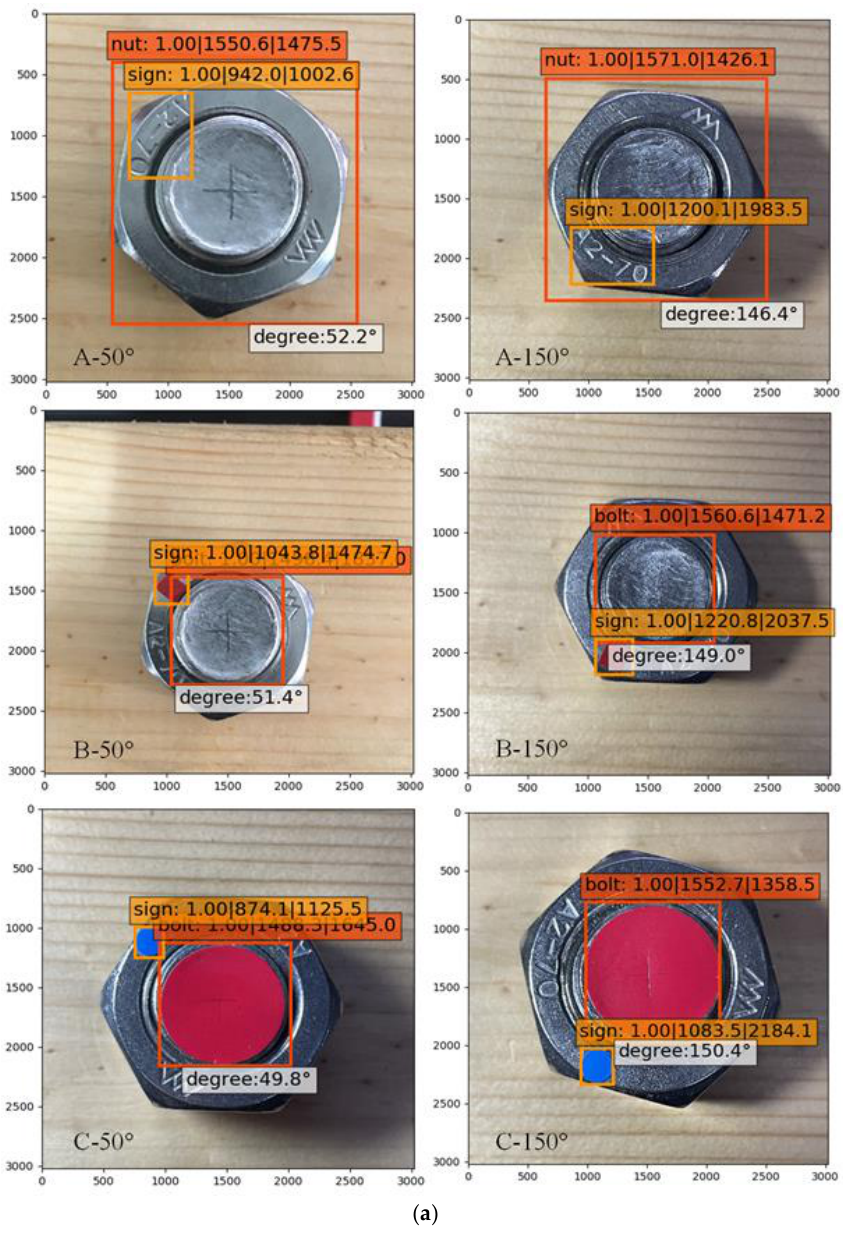
Figure 9. Best identification of rotation angles: ( a ) 50 ◦ and 150 ◦ ; ( b ) 250 ◦ and 350 ◦